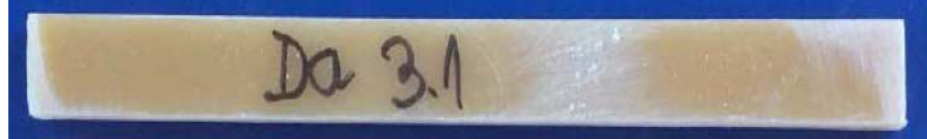
Figure 1. Hybrid resin sample.